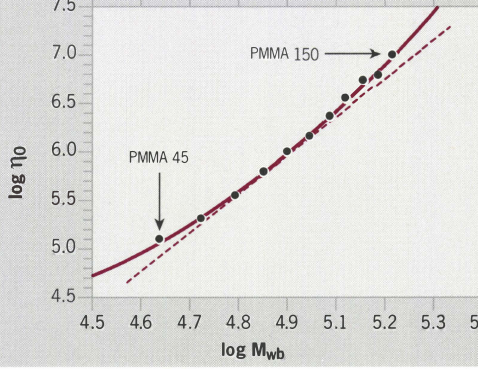
Fig. 3: Abhiingigkeit der Nu/lscherviskositiit 11 o vom Gewichtsmittel des Molekulargewichtes Mwb fur eine Homopolymer-Biendreihe Fig.3. Dependence of the limiting viscosity at zero shear rate 11 o on the weight average molecular weight Mwb for a series of homopolymer blends consisting of PMMA45 and PMMA150 Abb. 2: Auftragung der Gleich- -4.0 gewichtsnachgiebigkeit JeO gegen Mz/Mw im doppelt­ logarithmischen Ma13stab fur beide Serien syndiotaktischen PM MAs Fig.2. Log-log plot of the equilibrium compliance JeO vs. Mz!Mw for both series of syndiotactic